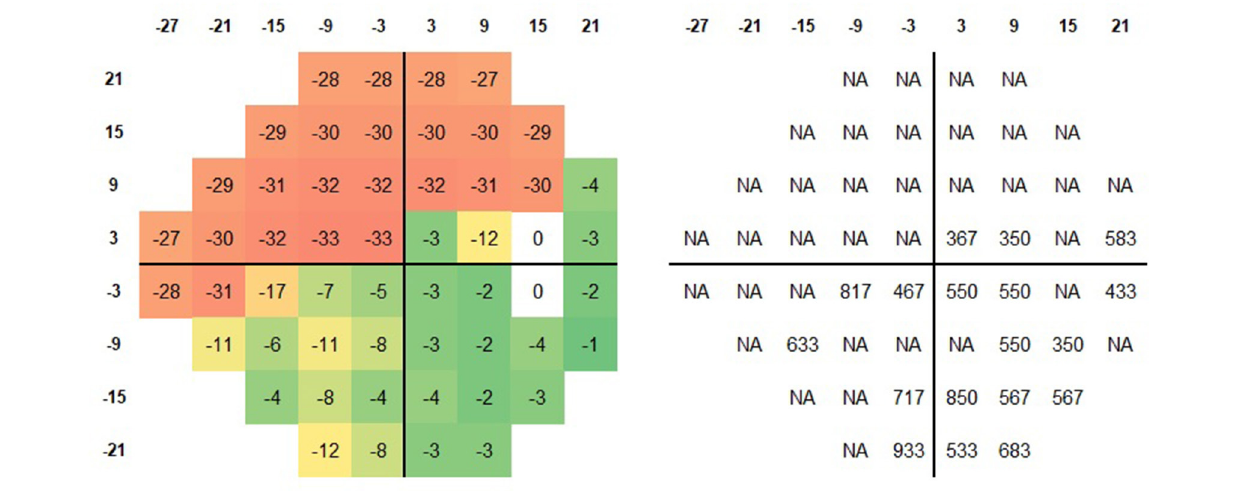
FIGURE 1 | Schematic representation of the 24-2 test grid. The local sensitivity deviation values (Left) and the corresponding SRT (Right) for the brightest stimuli for a patient with advanced glaucoma (MD − 18 dB) are plotted. In the majority of locations with incomplete sensitivity loss (green and yellow squares), an SRT was